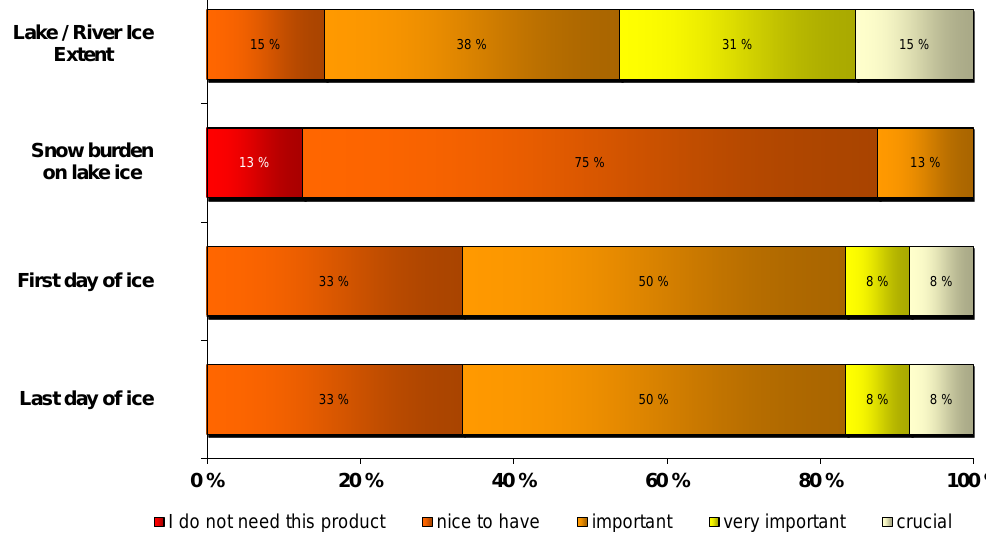
Figure 6. Relevance of lake ice products.